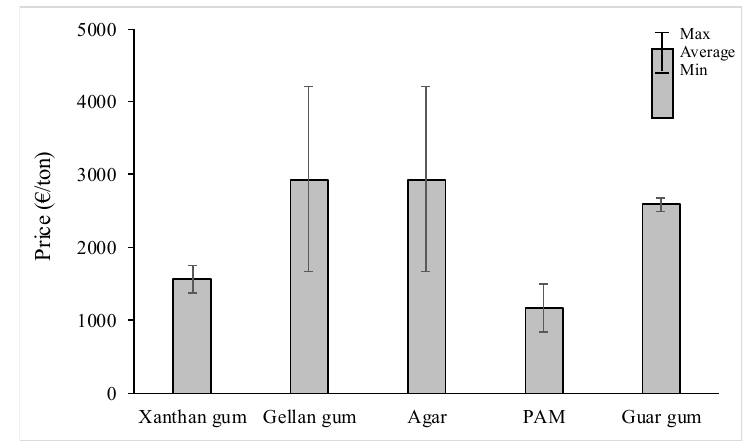
Figure 3. Prices of five common biopolymers (based on Jang [28]).